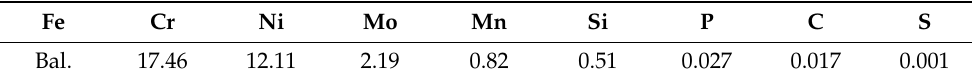
Table 1. Chemical composition of 316L steel